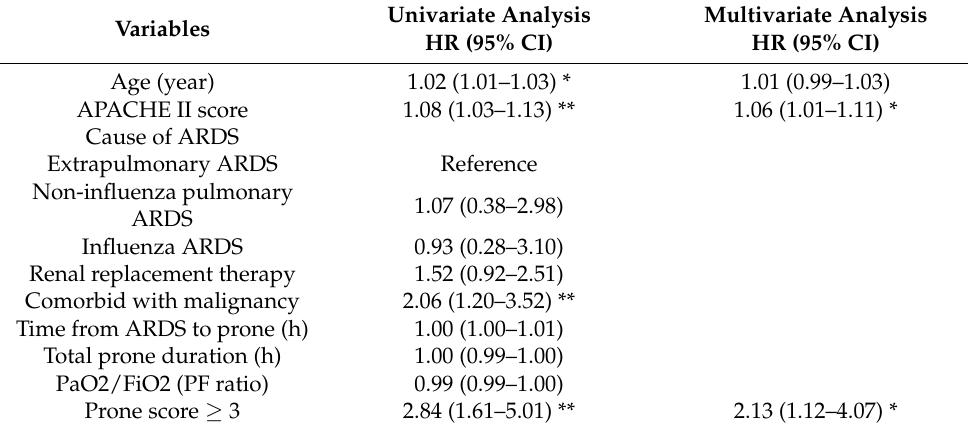
Table 4. Cox analysis of clinical variables associated with ICU mortality in patients with ARDS receiving early and prolonged prone positioning.